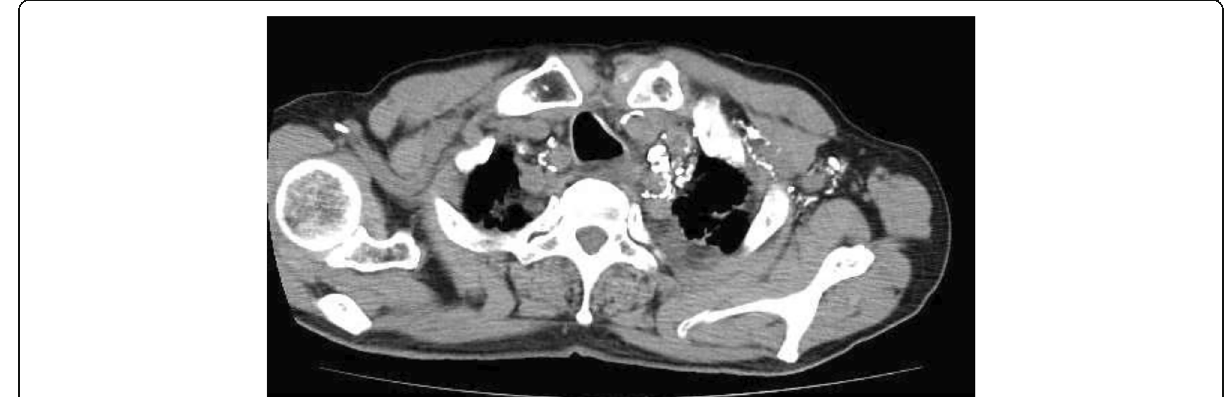
Fig. 1 Computed tomography image showing enhanced supraclavicular lymphatic